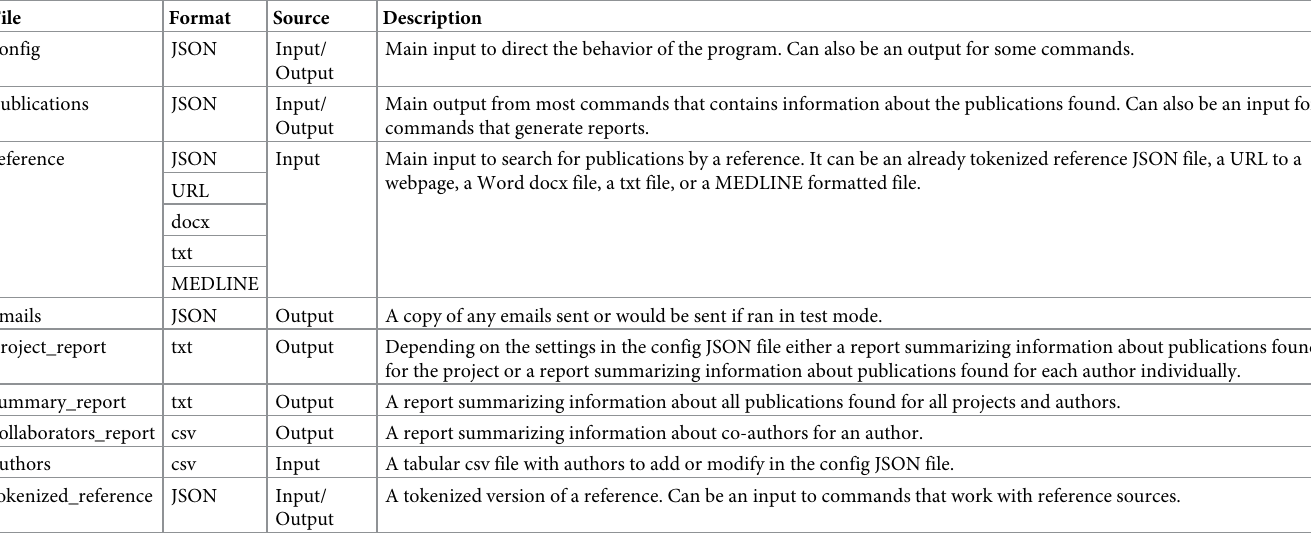
Table 3. Description of input and output file